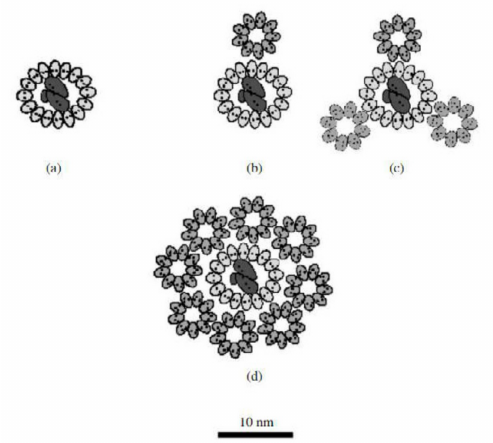
Figure 5. Model of a possible arrangement of a photosynthetic unit (LH1 and LH2 are localized around the reaction center (RC). ( a ) LH1 + RC Rhodospirillum rubrum growing at high light inten- sities, ( b ) LH1 + RC + LH2 Rhodopseudomonas palustris growing at low light intensities, ( c ) LH1 + RC + LH2 Rhodopseudomonas palustris growing at high light intensities, ( d ) LH1 + RC + LH2 Al-lochromatium minutissimum growing at low light intensities (data from Solovev and Erokhin, 2008